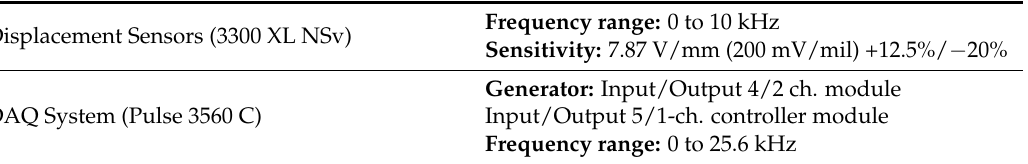
Table 1. Data acquisition (DAQ) system specifications.